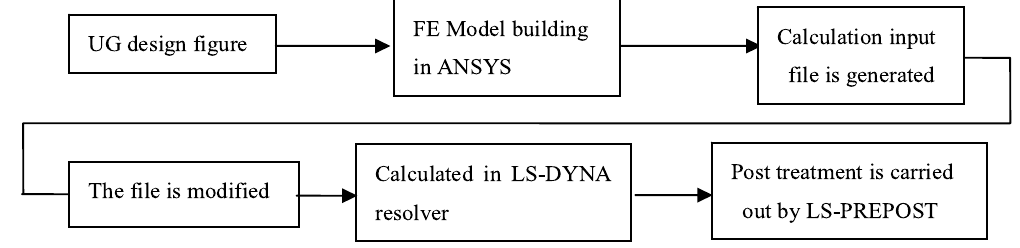
Fig. 1. The building process about combined model of UG and